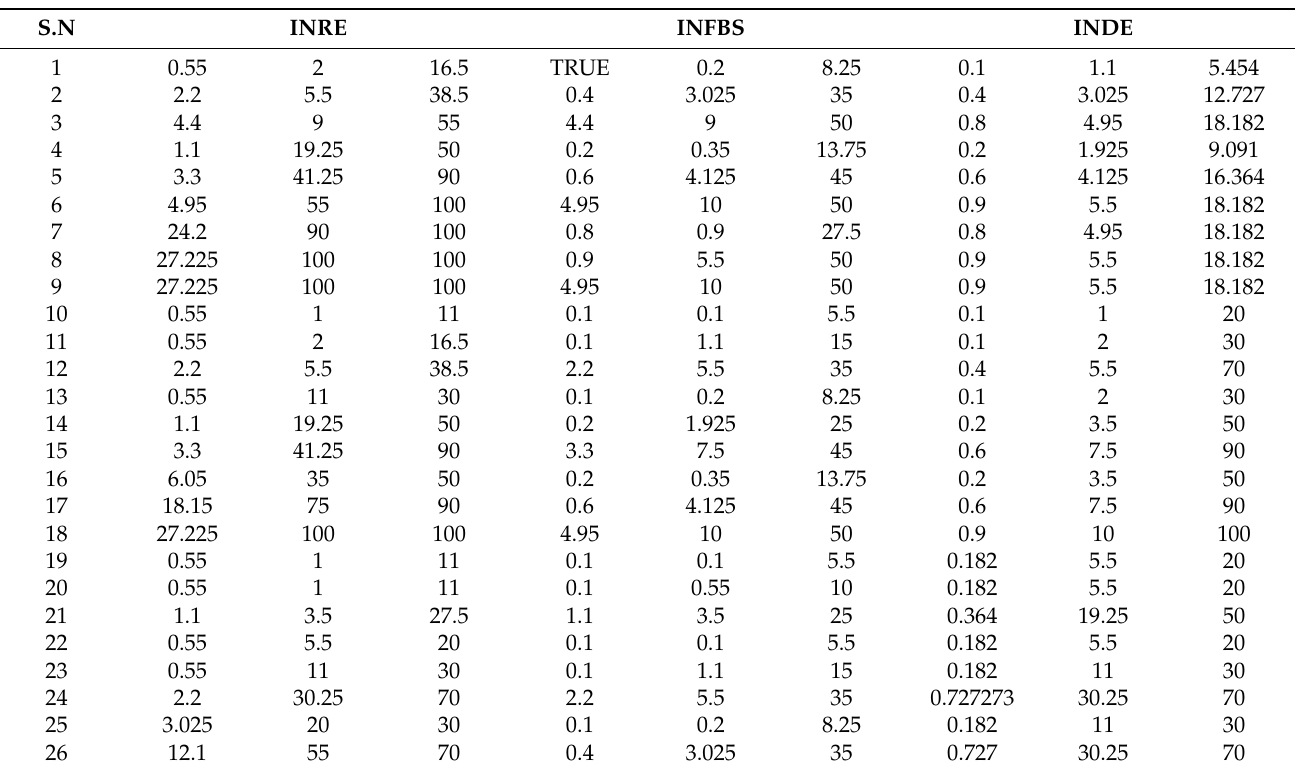
Table 8. Weighted normalized Fuzzy decision